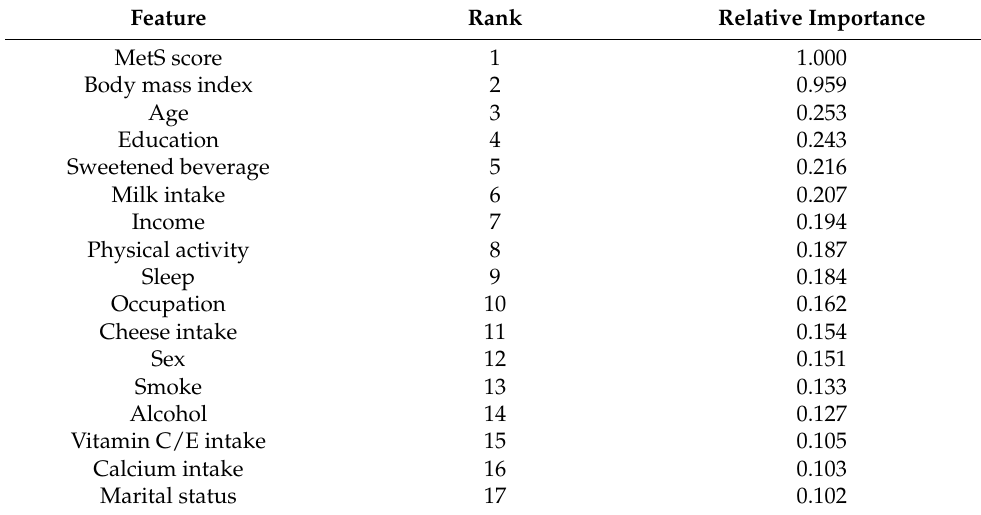
Table 1. Robust feature importance ranking